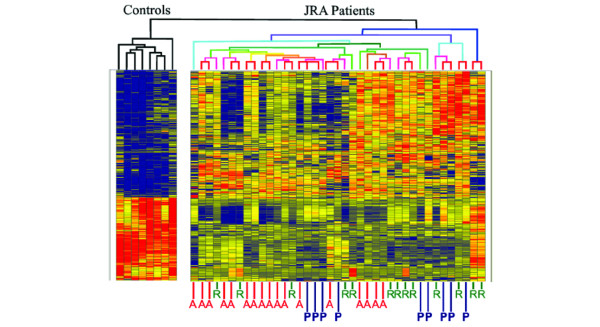
Hierarchical cluster analysis of microarray data in juvenile rheumatoid arthritis (JRA) neutrophils. Data show clustering of control subjects to the left of the grid based on patterns of gene expression. Data of children with JRA are scattered on the right side of the grid regardless of disease status. That is, data of children with active disease (A) cluster together with those of children with partially responsive disease (P) and inactive disease (fully responsive disease) (R).